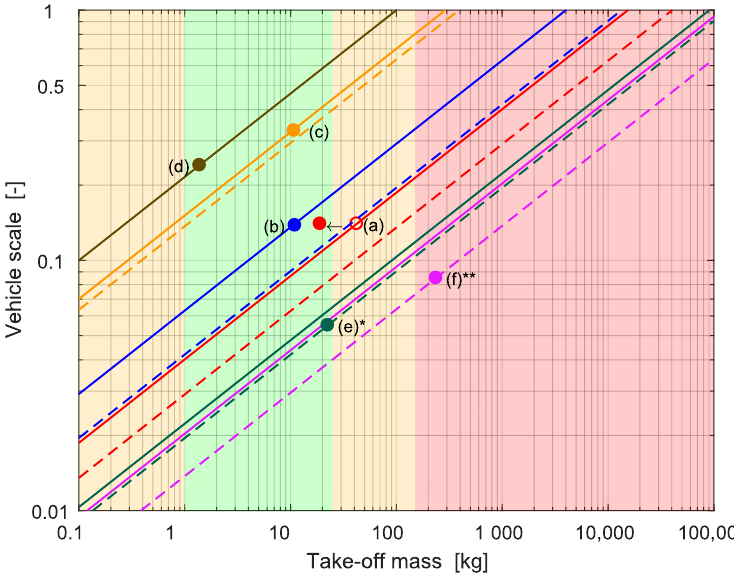
Figure 4. Take-off mass and scale factor according to dynamic similarity for SFT at sea level. Back- ground colours indicate relative complexity, considering the challenges and cost of manufacturing and operation. Solid lines represent similarity to the full-scale vehicle at sea level while dashed lines represent similarity to the full-scale vehicle at its design altitude. The GFF subscale model in case (a) is lighter than prescribed due to cost and regulations. Besides the aircraft described in Table 4, two complementary examples have been added: * (e) corresponds to NASA’s AirSTAR GTM-T2 [121], and ** (f) corresponds to NASA-Boeing’s X-48B [108], both scaled with respect to their design